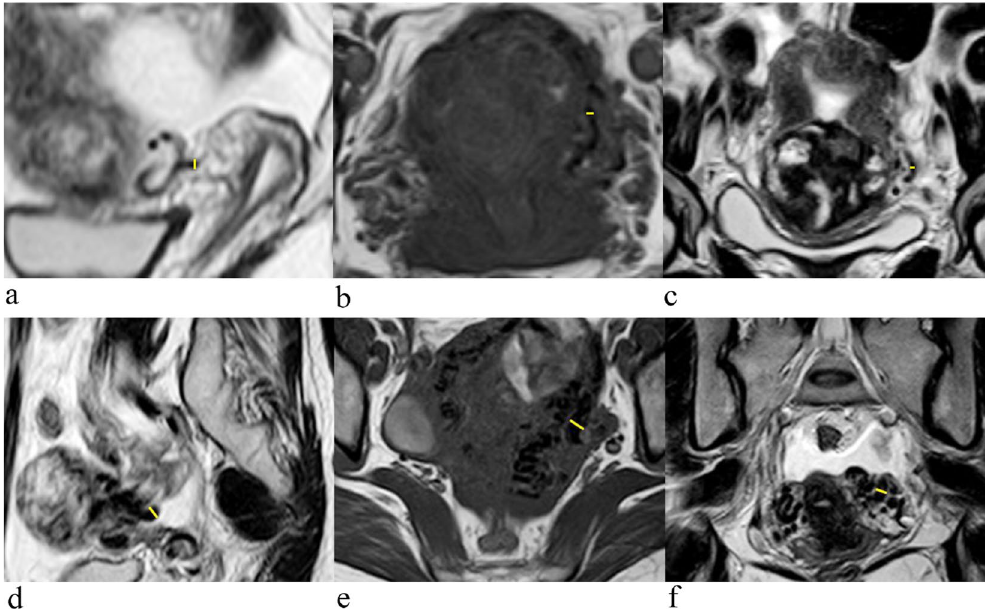
Figure 5. Images obtained of a 30-year-old woman with RPOC without uterine AVMs. The fv-D measurements in the parametrium on MRI. ( a ) Sagittal T2WI (fv-D = 2.3 mm). ( b ) Axial T1WI (fv-D = 2.0 mm). ( c ) Coronal T2WI (fv-D = 2.7 mm). The mean value is 2.3 mm. Images obtained of a 32-year-old woman with RPOC coexisting with a uterine AVM. The fv-D measurements in the parametrium on MRI. ( d ) Sagittal T2WI (fv-D = 5.5 mm). ( e ) Axial T1WI (fv-D = 5.4 mm). ( f ) Coronal T2WI (fv-D = 5.6 mm). The mean value is 5.5